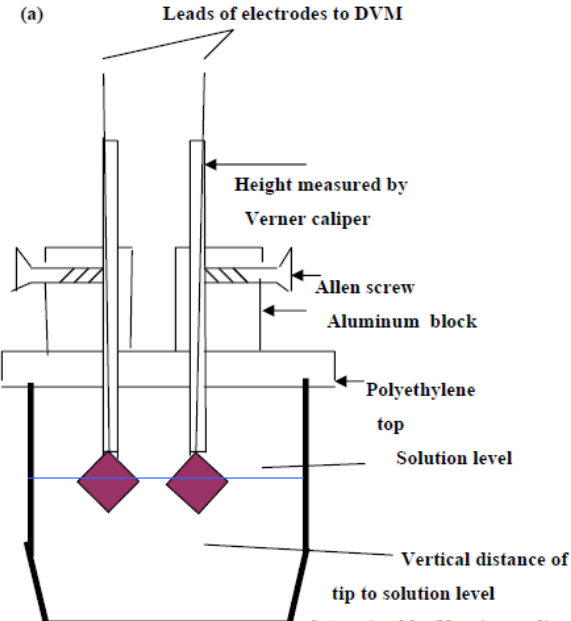
Figure 5. (a) General setup of cell. (b) Plan view of square polyethylene top for electrode; (c) Electrode used in the